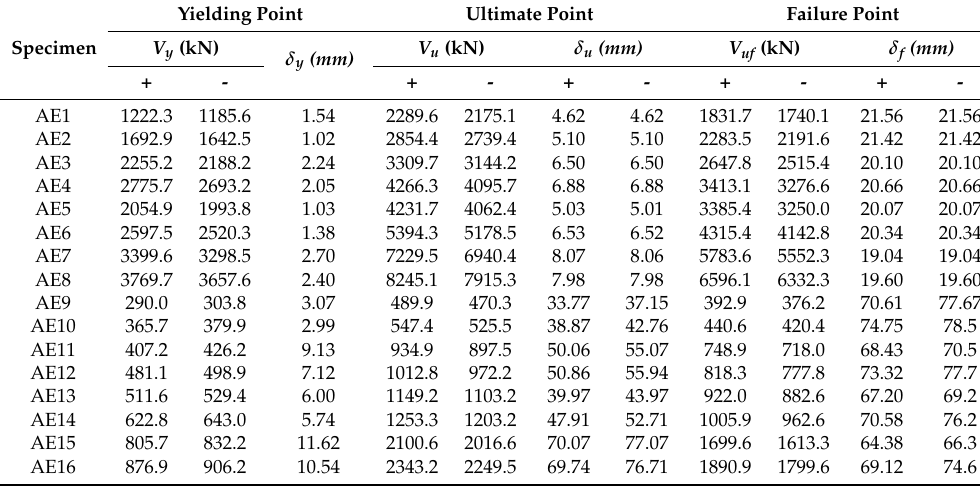
Table 5. Cyclic analysis results of the parametric